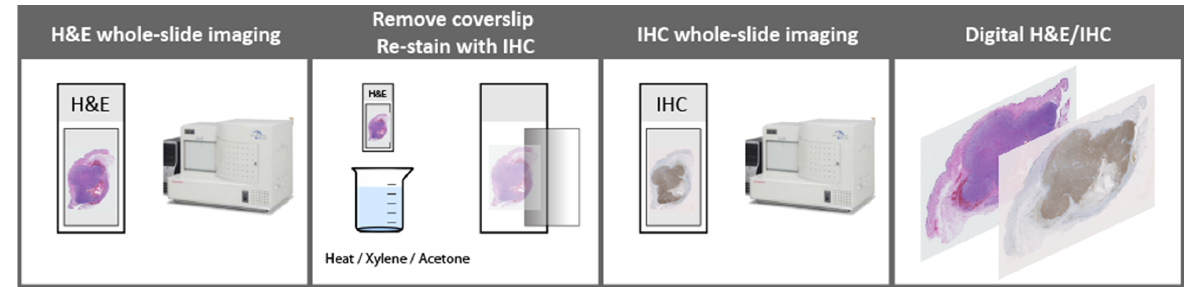
Figure 2. Digital H&E/IHC dual staining of the same tissue section. Initially, the H&E stain is digitized. Then, the glass coverslip is removed. This may be conducted chemically or by heat. Afterwards, chromogenic immunohistochemistry is performed directly on the H&E glass slide and re-scanned. Finally, the two digital images of H&E and immunohistochemistry are superimposed to form a digital dual stain.